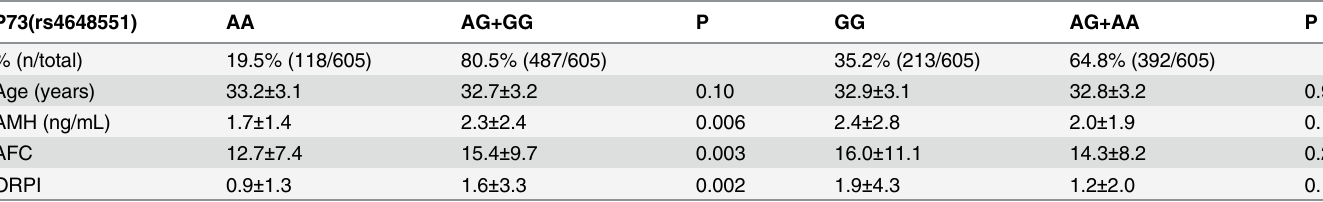
Table 3. Mean of age, AMH level, AFC and ORPI of associated SNP genotypes in the study group.